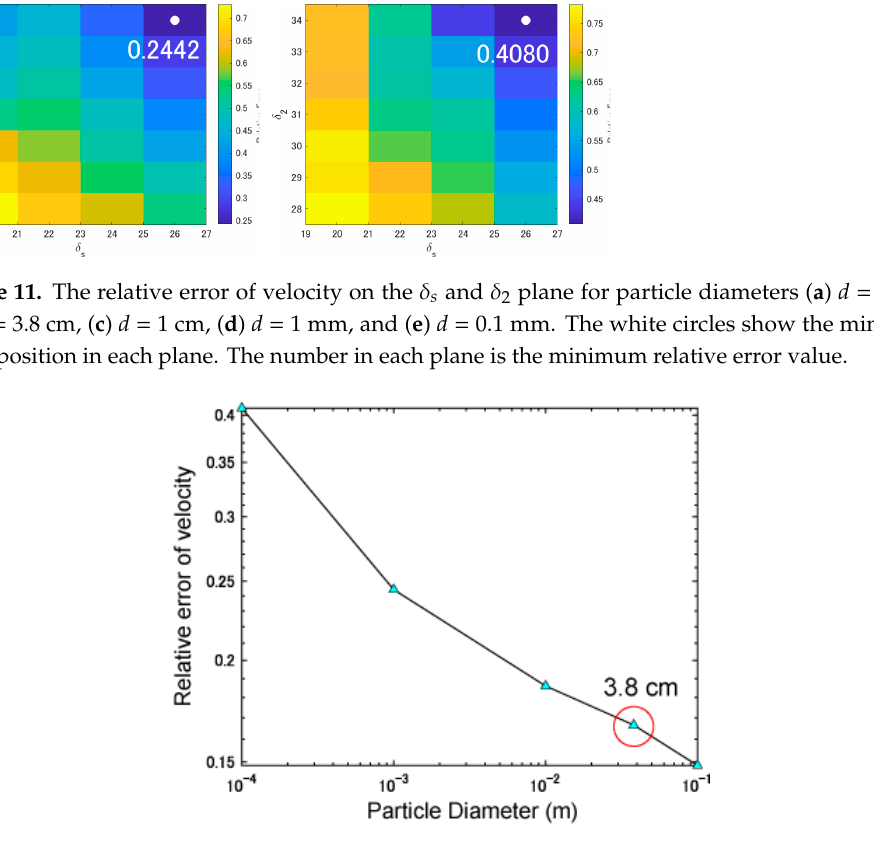
Figure 12. Minimum relative errors of velocity between the simulated and experimental velocities against the particle diameter d . The simulations are implemented with δ s = 22 − 26 ◦ and δ 2 = 28 − 32 ◦ .